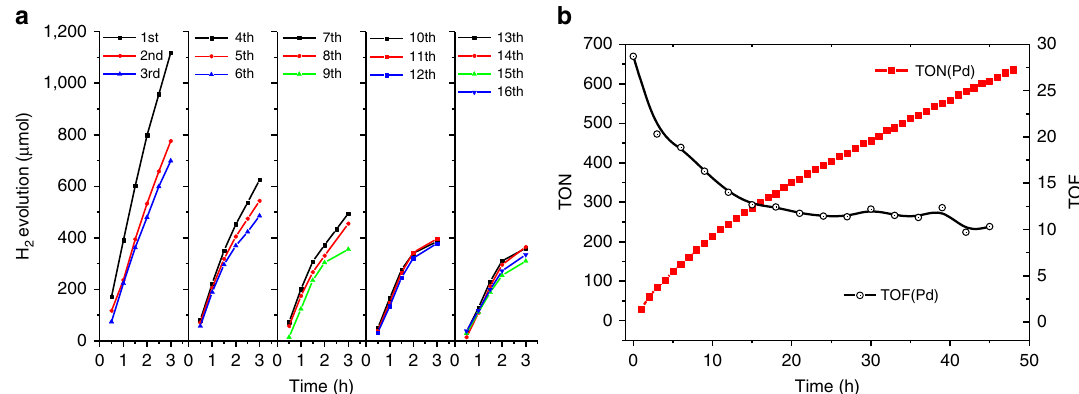
Figure 3 | Long-term H 2 evolution. ( a ) H 2 production of consecutive 16 3-h runs. ( b ) Accumulated TONs and TOFs based on Pd-centre in catalyst durability test over 48h. TON ¼ n (H 2 )/ n (Pd), TOF ¼ d (TON) / d t